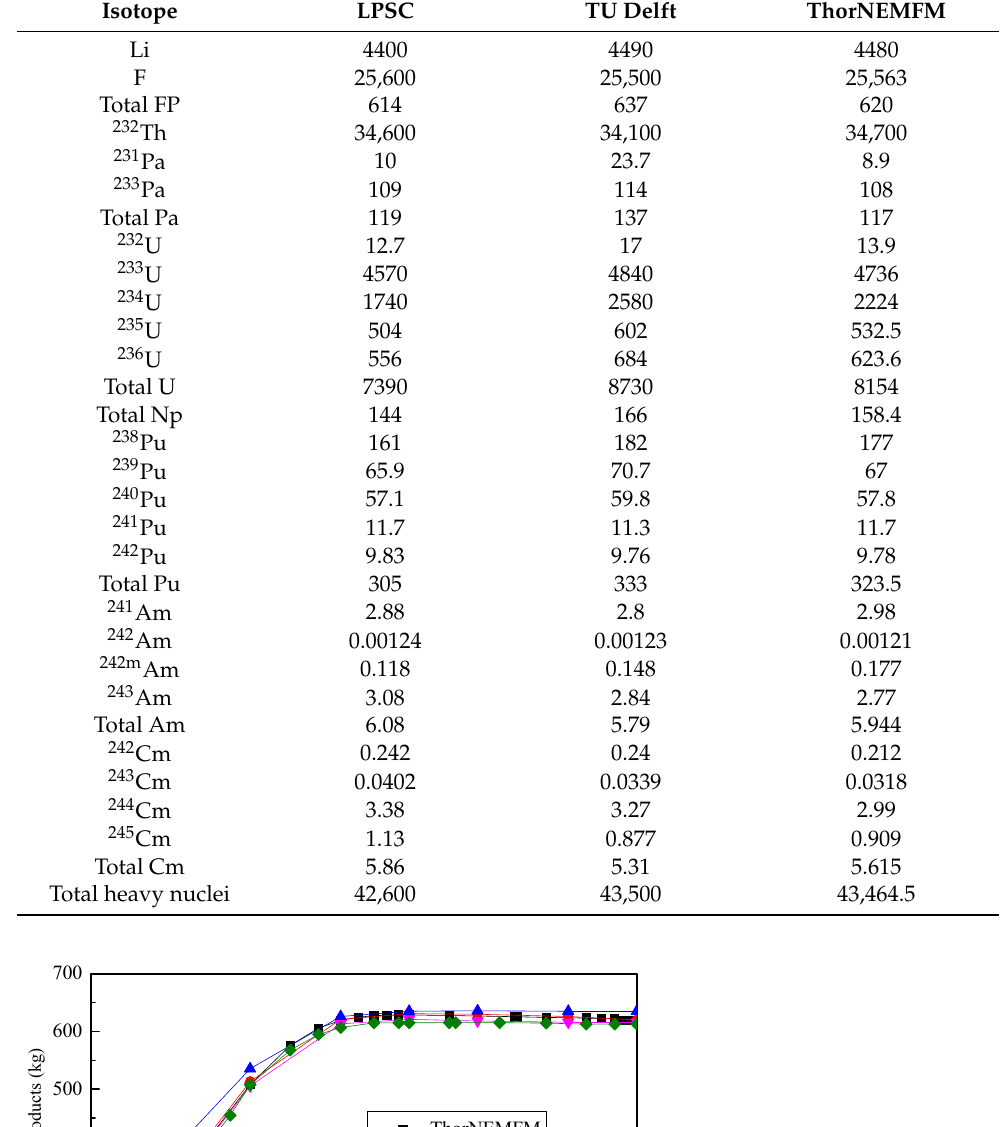
Table 5. Inventories of heavy nuclei at equilibrium state in a 233 U-started MSFR in kg.